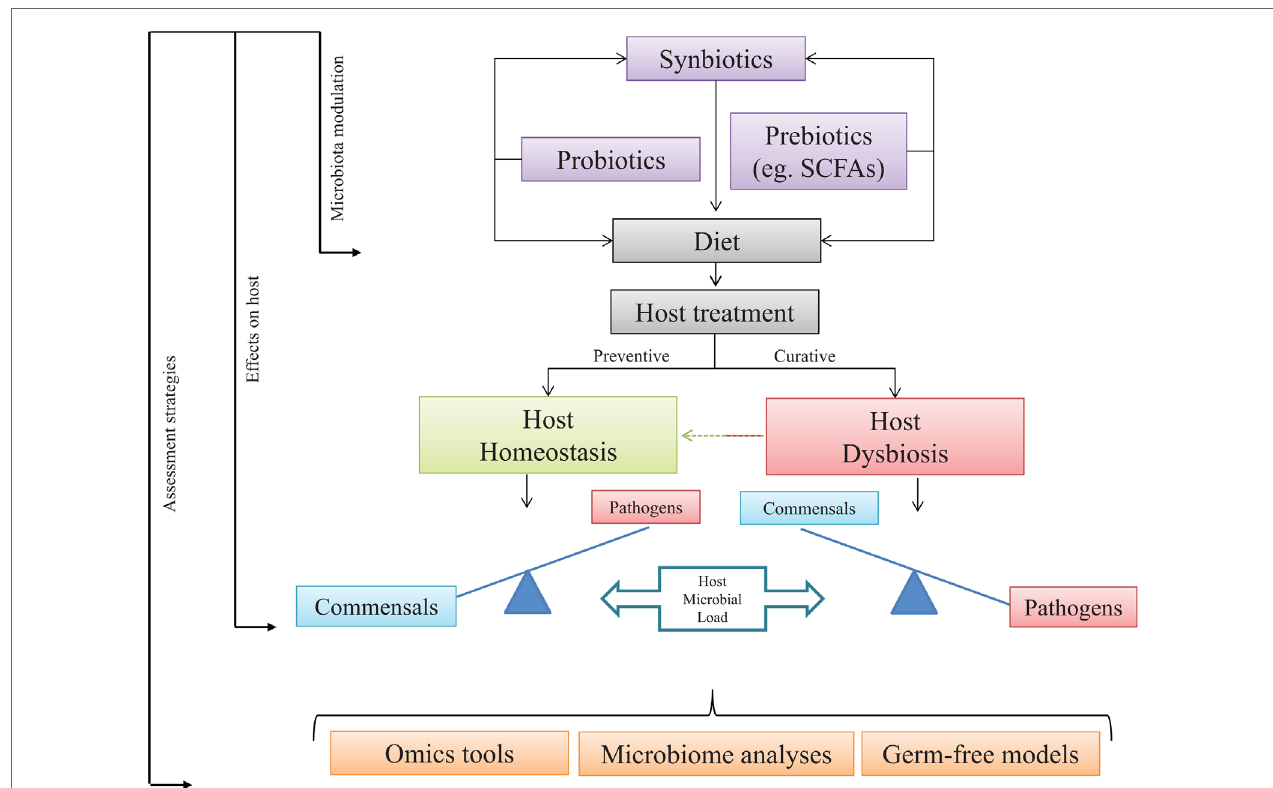
FiGURe 2 | Host-microbial load under health and dysbiosis . Addition in diet of exogenous microbial sources may increase fish health through a host–microbe positive loop. Commensal gut microbes might be modulated by dietary administration of target microbes, non-digestible elements, or a mix of both. Expected output should turn in preventive or curative strategies. The use of pro-, pre-, and/or synbiotics is expected to restore the homeostatic stage. Assessment of the selected approach might be quantified, modeled, or dissected using omics tools, germ-free models, and microbiome